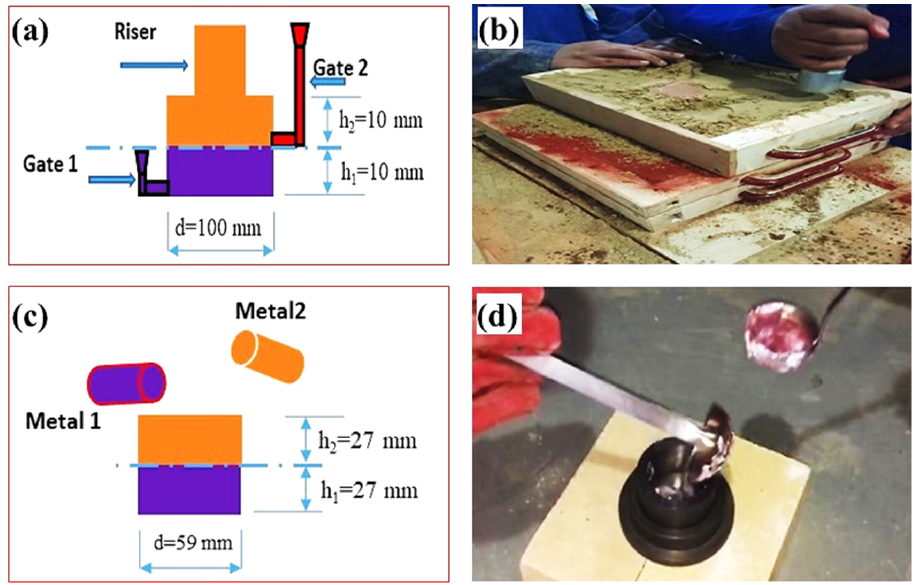
Figure 1. Gating and risering systems ( a ), sand molding of bimetal sand casting ( b ), metallic mould top pouring ( c ), and double pouring of metallic mould casting ( d ), the two colors represent M1 and M2.